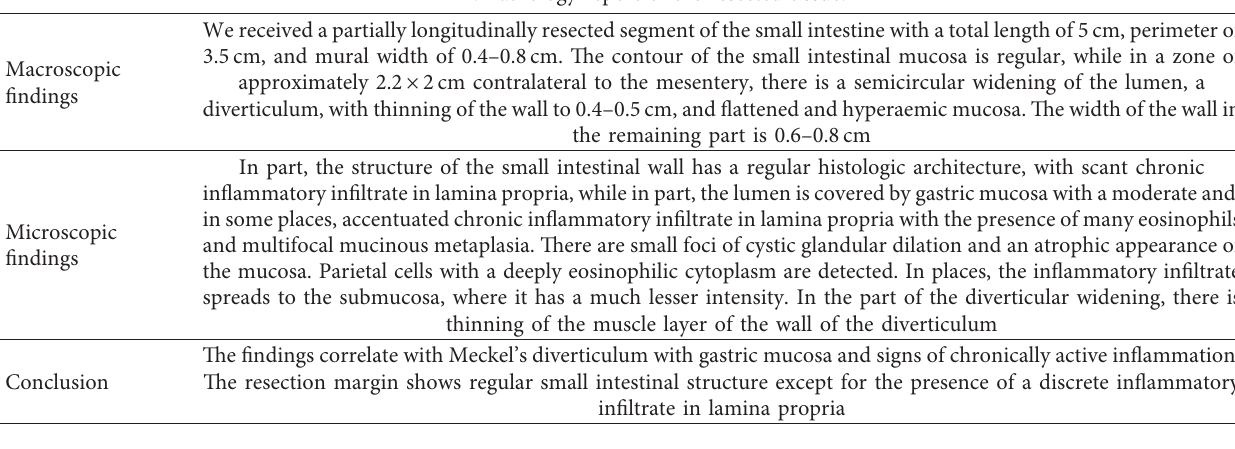
Figure 2: Abdominal scintigraphy with 99m Tc pertechnetate (Meckel scan) showed abnormal accumulation of the radioisotope indicating the presence of ectopic gastric mucosa. The black arrows point to the areas of abnormal Table 1: Pathology report of the resected tissue.